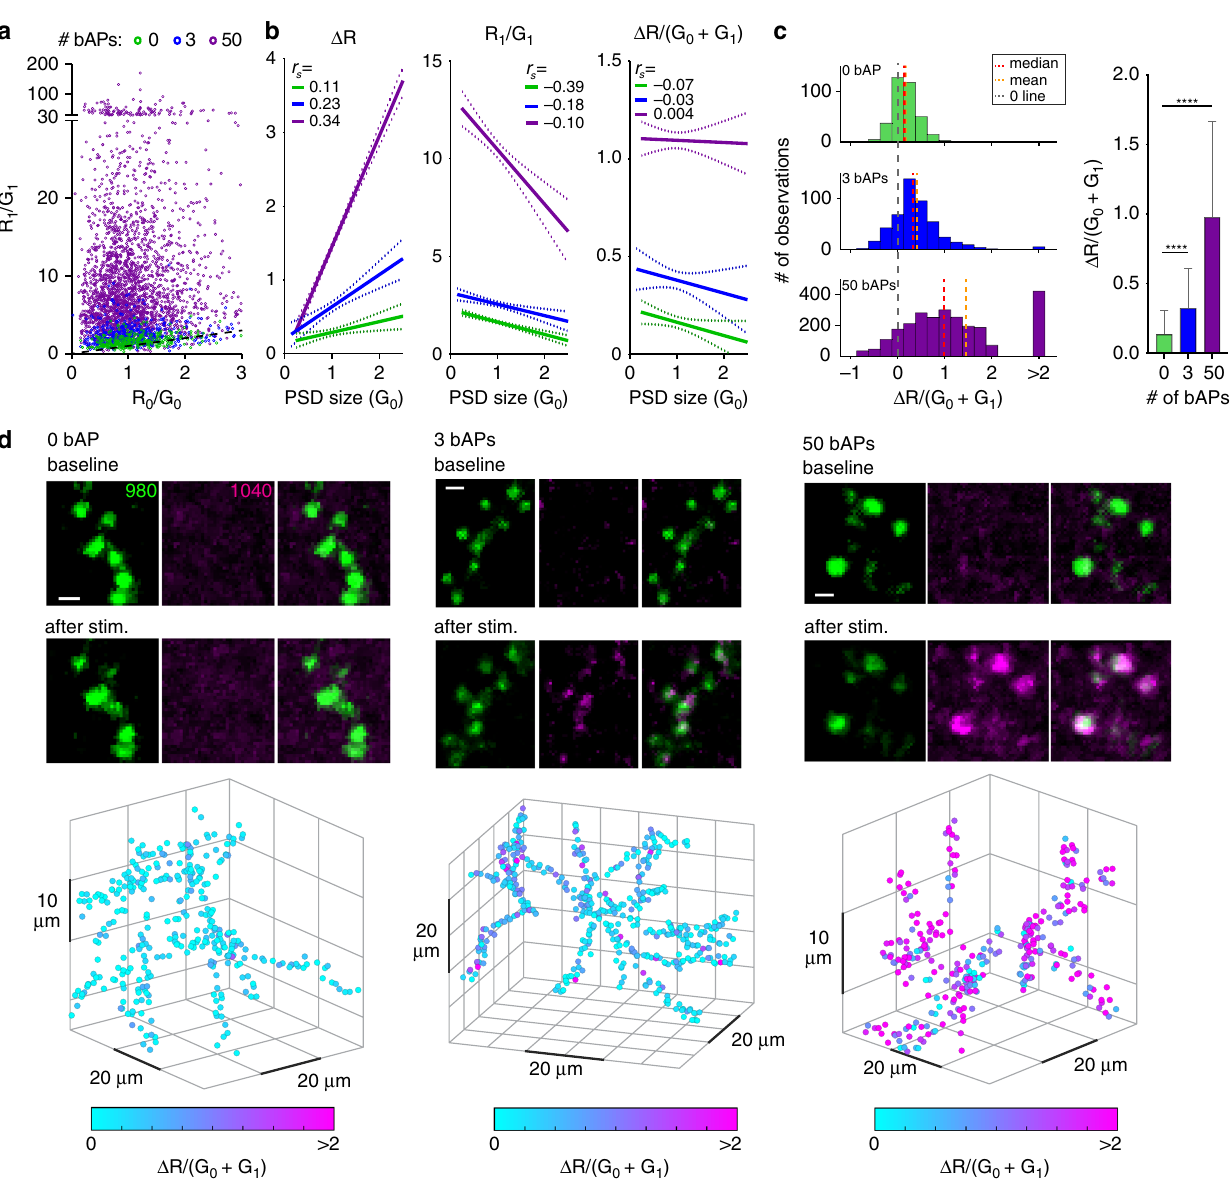
Fig. 4 PostSynTagMA photoconversion with back-propagating action potentials (bAPs). 2P image stacks of postSynTagMA expressing CA1 pyramidal neurons were taken before and after 15 pairings of trains of bAPs with photoconverting violet light (395 nm, 16 mW mm − 2 , 500 ms duration, 1 s delay). Synaptic transmission was blocked. a R/G ratios of individual synapses before (R 0 /G 0 ) vs after (R 1 /G 1 ) photoconversion. Note the variability in photoconversion within conditions. Dotted black line is the unity line. Magenta: 50 bAPs. Blue: 3 bAPs. Green: 0 bAP. b Three different metrics vs. PSD size (linear regression lines with 95% con fi dence intervals, see Supplementary Fig. 6a-c for regressions). Δ R is positively correlated with PSD size (0 bAPs: r s = 0.11, p = 0.03; 3 bAPs: r s = 0.23, p < 0.0001; 50 bAPs: r s = 0.34, p < 0.0001). Normalizing Δ R by (G 0 + G 1 ) removes the correlation with PSD size (0 bAP: